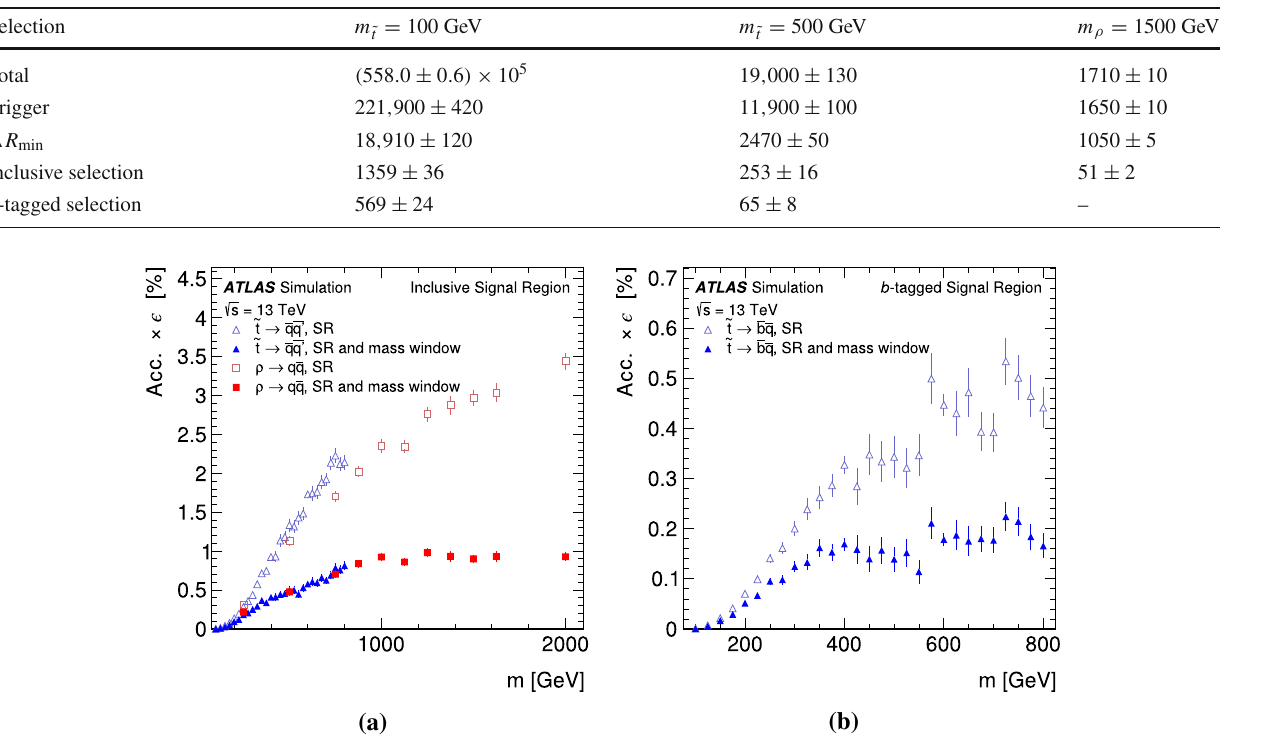
tail extending to low m avg values, degrading the efficiency of the mass window selection. Table 1 MC predictions of the number of signal events correspond- ing to 36.7 fb − 1 of data after applying each of the event selection requirements, except for the mass window. Top squark masses of for each selection